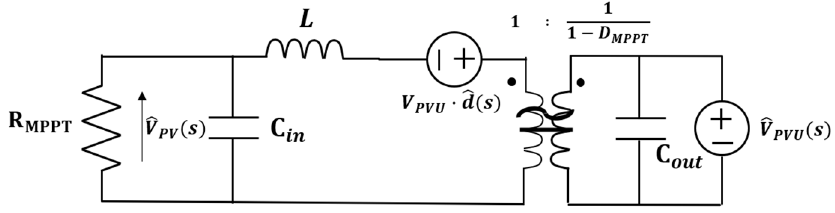
Figure A1. Small signal low-frequency equivalent circuit of Boost based PVU.